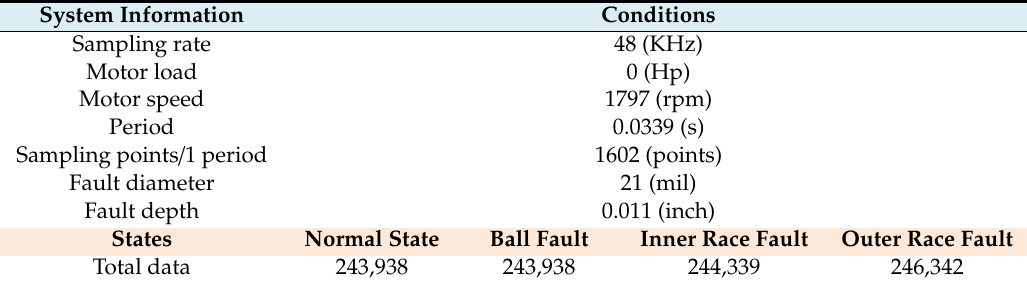
Table 2. The detailed conditions of four stats in the considered ball-bearing